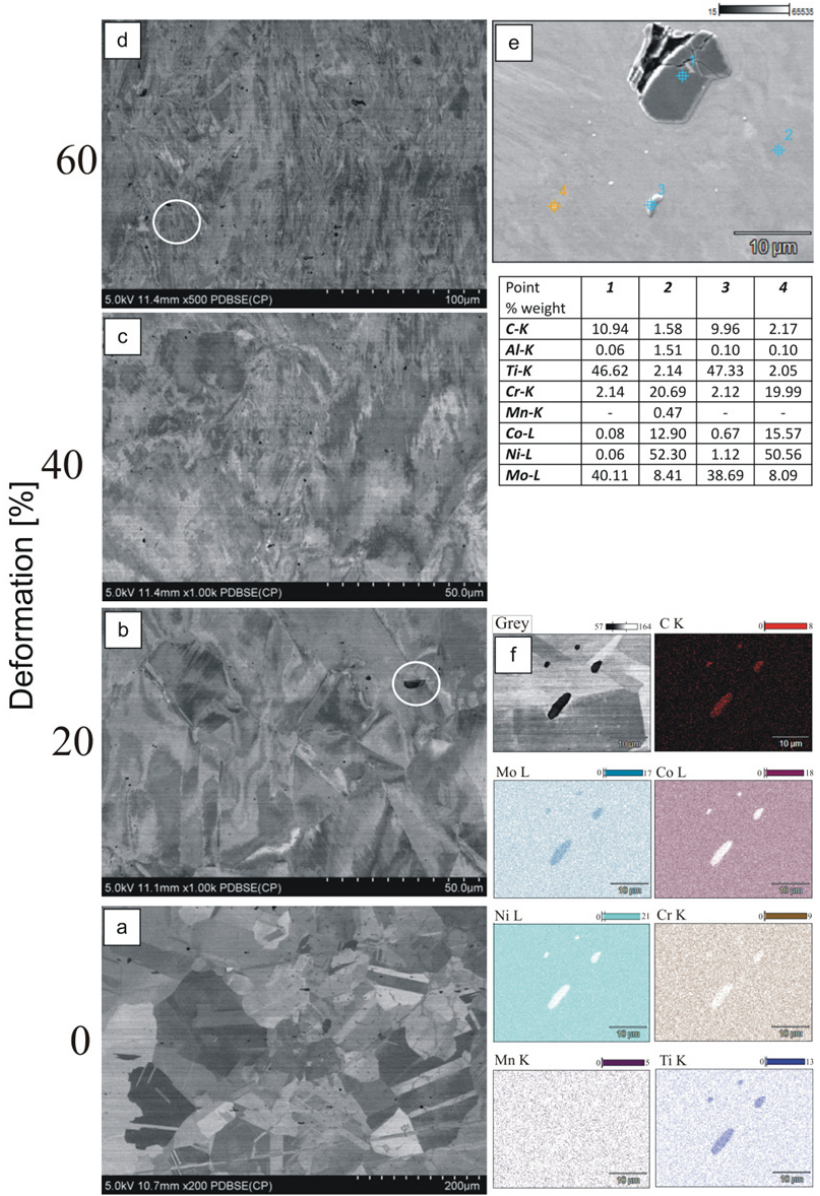
Figure 7. Microstructure of as-cast samples and point analysis of the chemical composition (60% deformation). ( a ) base as-cast sample; ( b ) 20% deformation; ( c ) 40% deformation; ( d ) 60% deformation (mapping). ( e ) point analysis of the chemical composition; ( f ) chemical analysis composition.